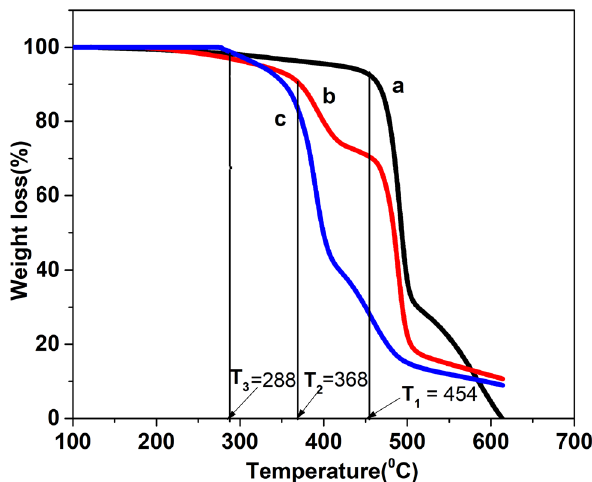
Fig. 4 DSC curves of a PVdF b PVdF–PMMA (80:20) c PVdF– PMMA (50:50) nanofibrous membranes